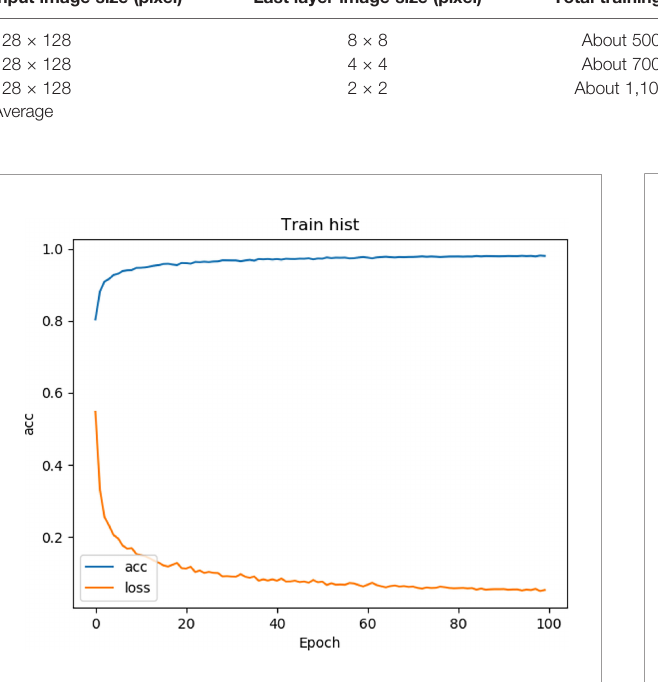
FIGURE 12 | Training result [FR2PAttU-Net (kernel = 3)].